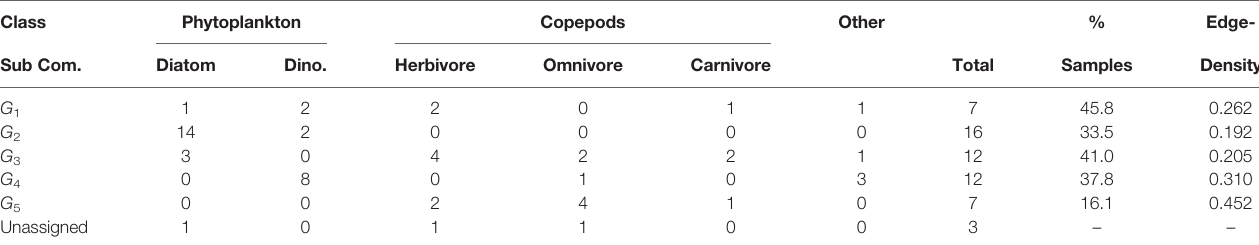
TABLE 4 | Breakdown of functional classi fi cation of sub-community membership, total unique members, proportion of total samples in which each sub-community is observed, and edge-density for each sub-community. Class Phytoplankton Copepods Other % Edge- Sub Com. Diatom